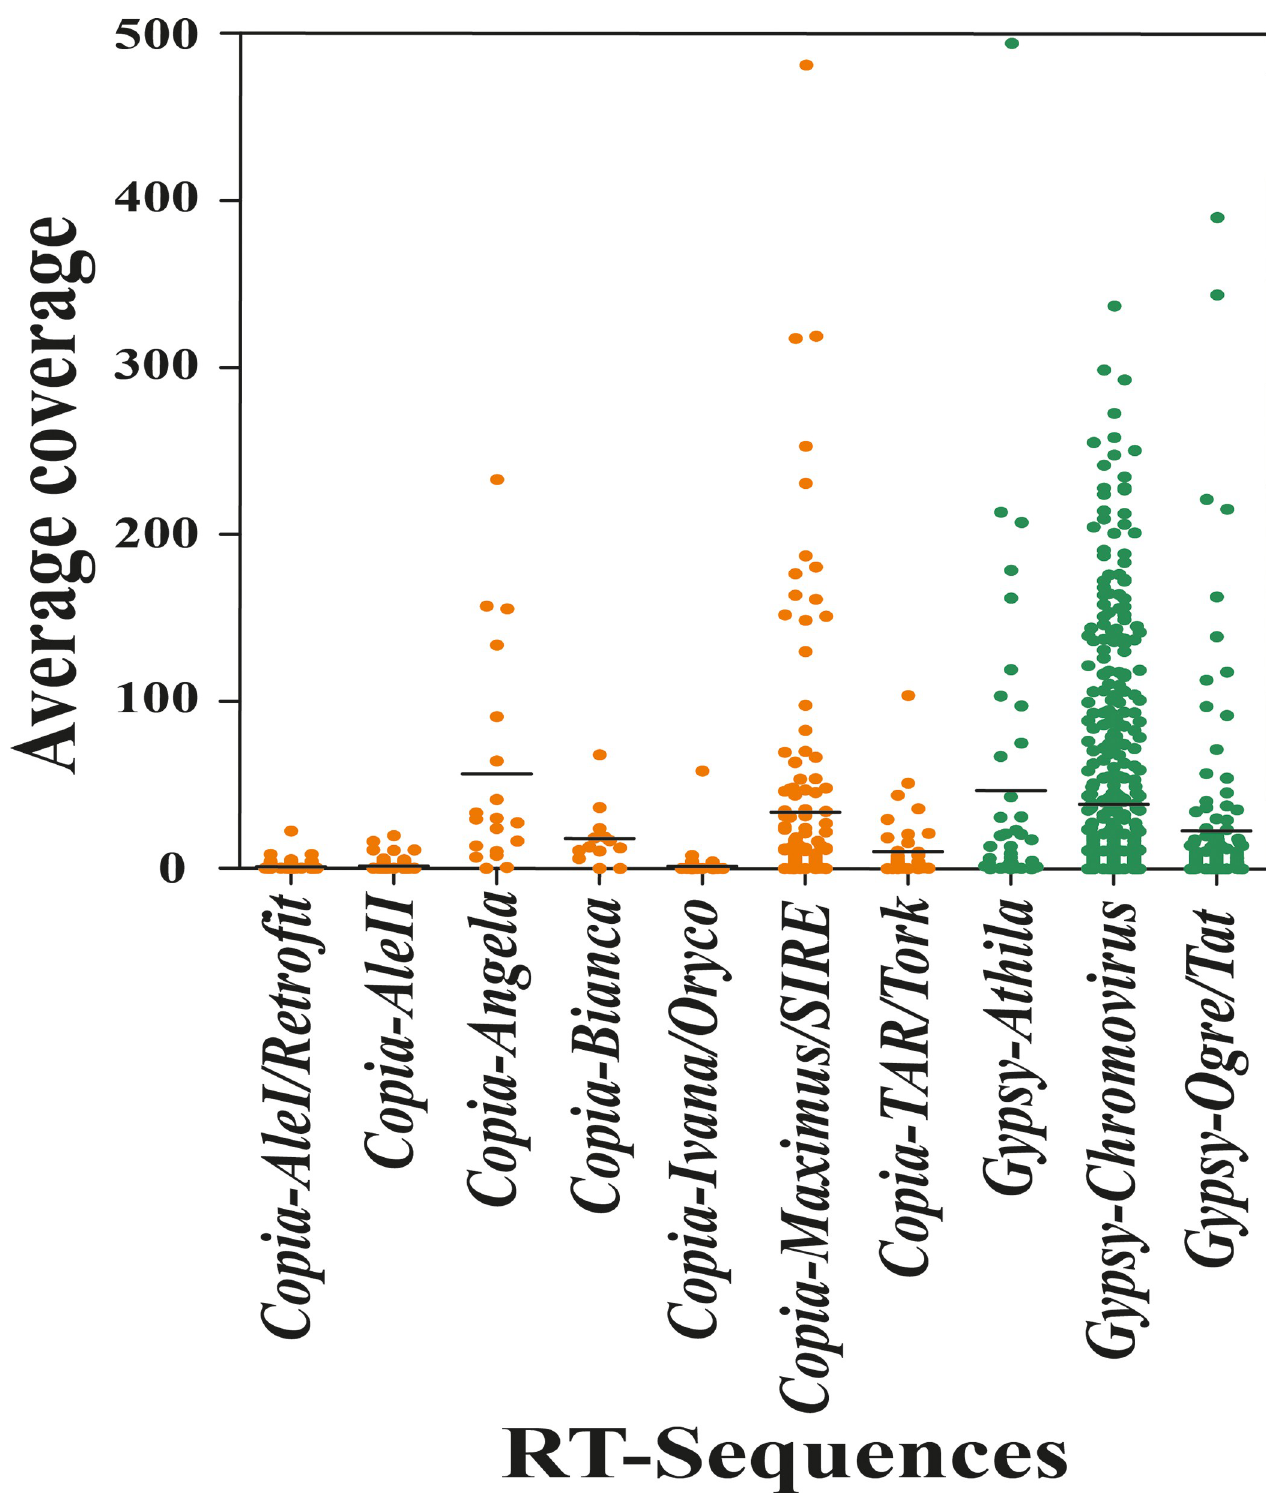
Fig 2. Average coverage of each of 1,807 unique reverse transcriptase (RT)-encoding sequences identified in the sunflower genomes, separated according to the long terminal repeat-retrotransposon lineage to which the RT sequence belongs. Bar represents the mean average coverage of each lineage.